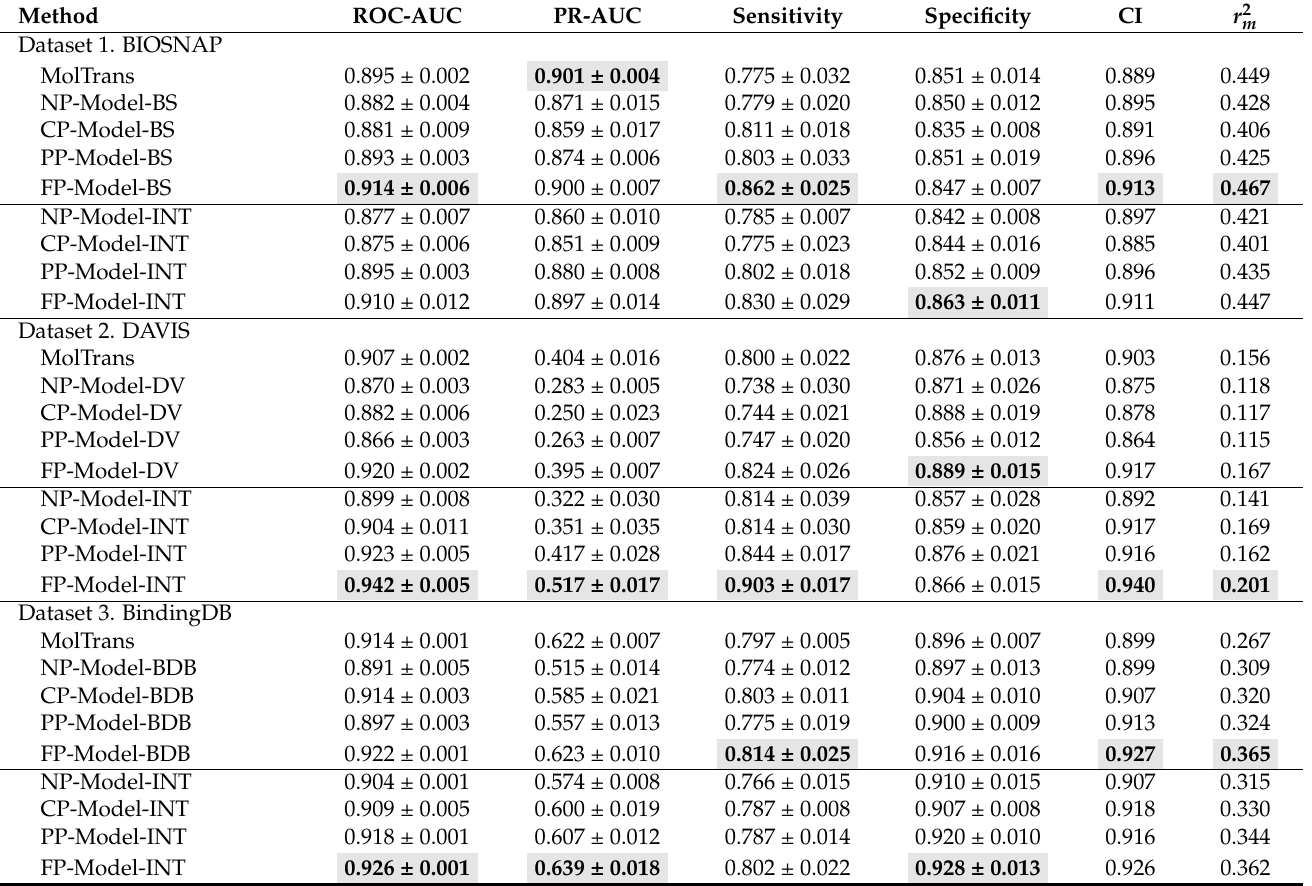
Table 4. Performance comparison. ROC-AUC , PR-AUC , Sensitivity , and Specificity were measured over five random runs to accurately compare the performance with that of the cited MolTrans paper. CI and r 2 m compare the performance of the proposed model with the performance when a metric is added to the published MolTrans model. The highest performances among the metrics used to evaluate each dataset are shown in bold on a gray